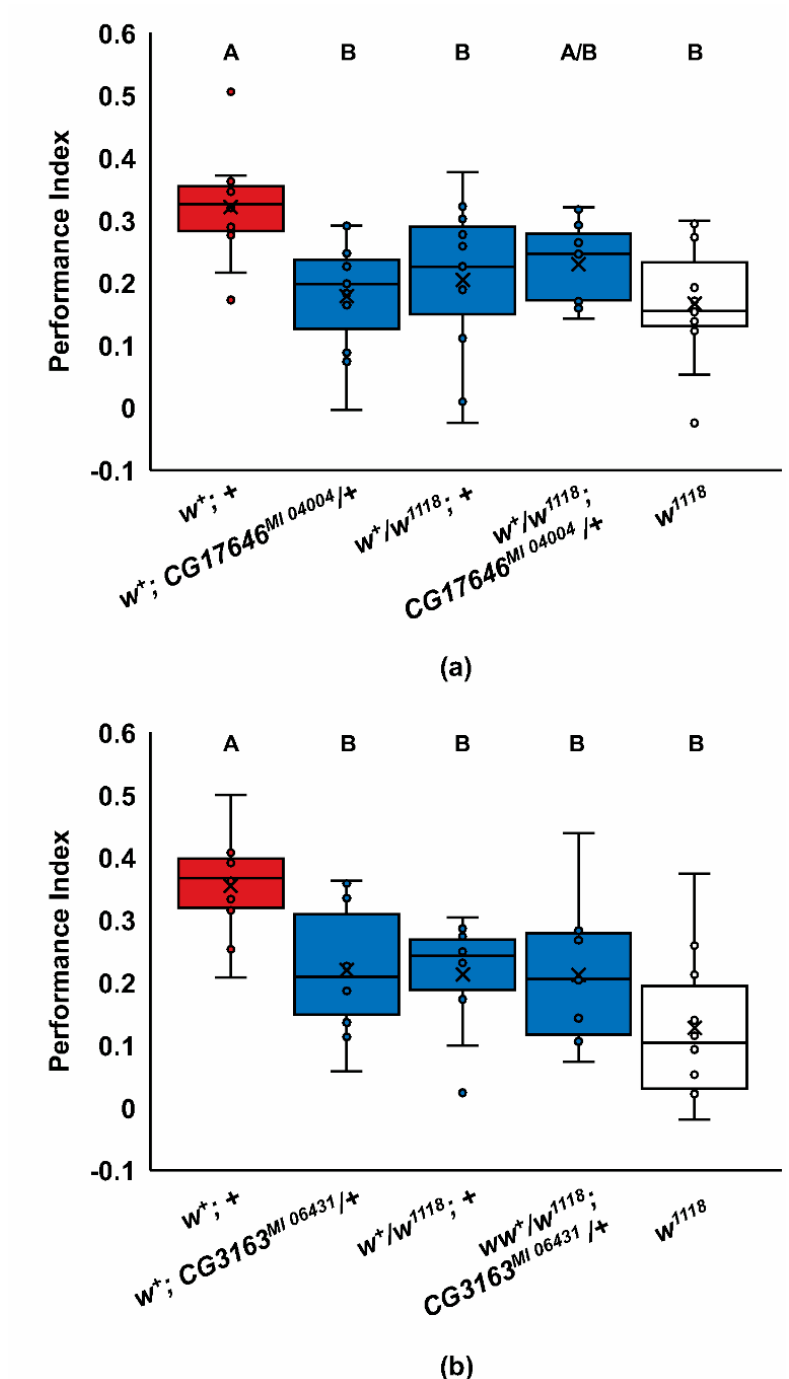
Figure 3. Reduced one-trial learning for Drosophila ABCG mutants is not additive with w 1118 . ( a ) Crosses were made to produce CG17646 MI 04004 heterozygotes, w 1118 heterozygotes, or transheterozy- gotes of w 1118 and CG17646 MI 04004 . The w 1118 and CG17646 MI 04004 alleles have dominant learning phe- notypes and are not additive for reduced acquisition (ANOVA, Adj. R 2 = 0.205, F 4,50 = 4.485, p < 0.004; Tukey post hoc, p < 0.05; n = 11); ( b ) crosses were made to produce CG3164 MI 064314 heterozygotes, w 1118 heterozygotes, or trans-heterozygotes of w 1118 and CG3164 MI 06431 . The w 1118 and CG3164 MI 06431 alleles have dominant learning phenotypes and are not additive for reduced acquisition (ANOVA, Adj. R 2 = 0.299, F 4,45 = 6.227, p < 0.001; Tukey post hoc, p < 0.05; n = 10). In panels a and b, groups that do not share letters above the box plots are significantly different from each other according to the Tukey post hoc test ( p < 0.05).